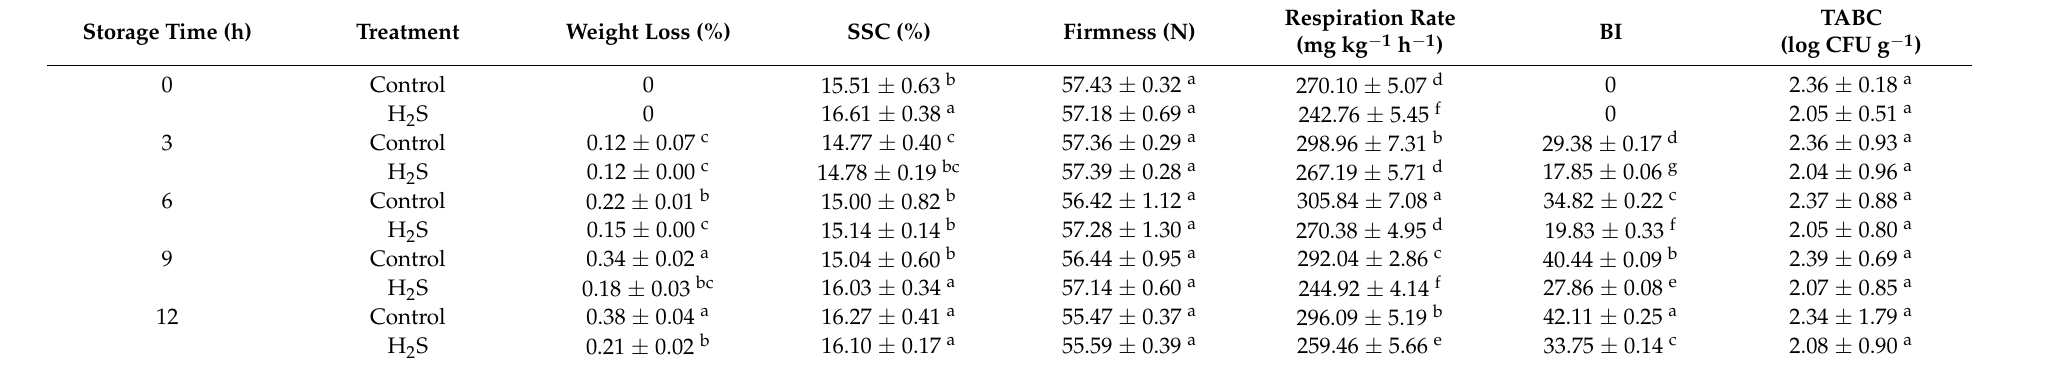
Table 1. Effects of H 2 S treatment on weight loss, SSC, firmness, respiration rate, BI, and TABC in fresh-cut peaches during storage.